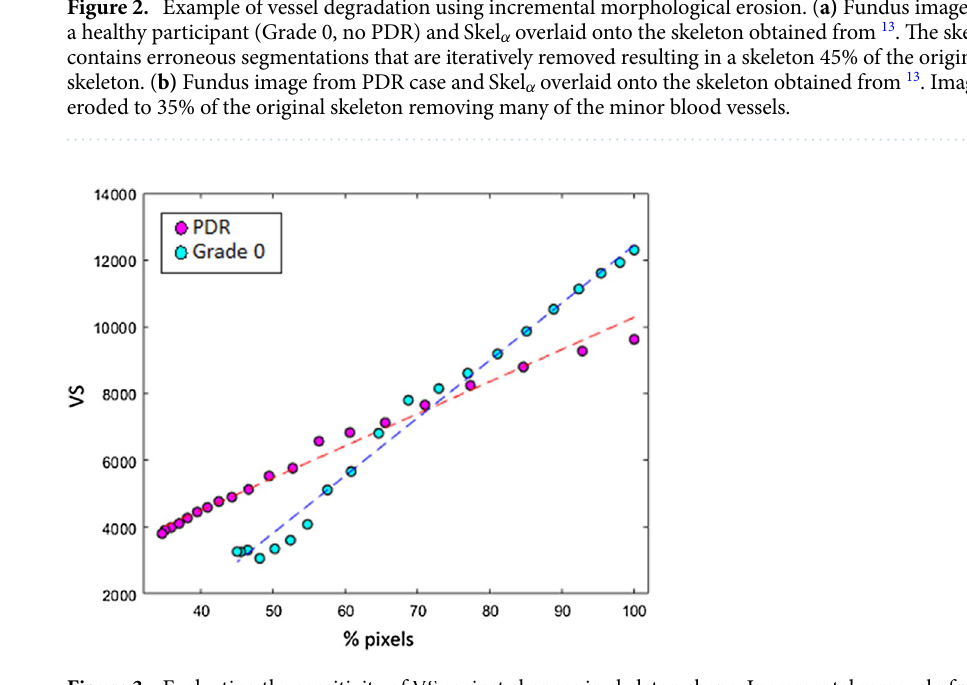
Figure 3. Evaluating the sensitivity of VS against changes in skeleton shape. Incremental removal of pixels (expressed as a percentage of the number of pixels of the original skeleton) against the candidate VS parameter for images in Fig. 2. As the skeleton is degraded the VS parameter also decreases, indicating that it is modelling change in vascular